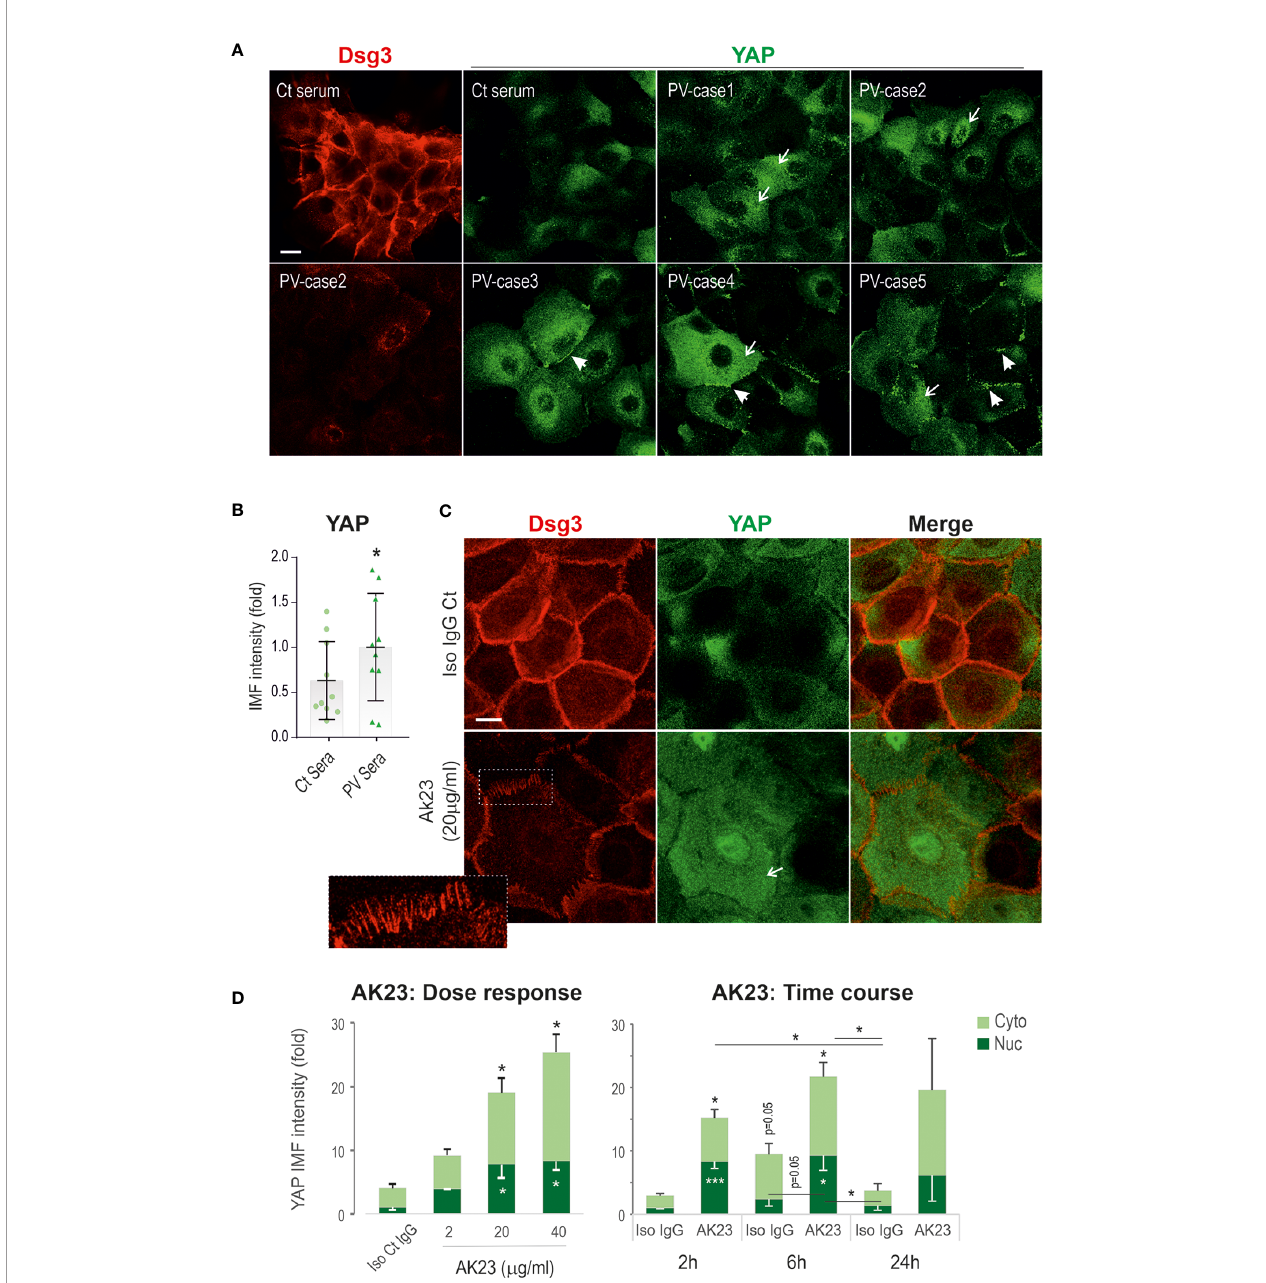
FIGURE 2 | Treatment of keratinocytes with PV sera or the pathogenic monoclonal antibody against Dsg3 results in increased YAP expression. (A) Confocal images of N/TERT cells double-labeled for Dsg3 (5H10, red) and YAP (green). Cells were seeded on coverslips at approximately 80% con fl uent densities (~2.5x10 5 /well) one day before being treated with PV sera (40%) in KSFM (Ca ++ 90µM) alongside control serum overnight. Then, the medium was replaced with KSFM with normal calcium (1.8mM) plus PV sera at the same concentration of 40% and cultured for further 5 hours (24 hours PV sera in total) before fi xation. Coverslips were immunostained for the indicated proteins. Increased cytoplasmic YAP (arrows) with aggregations at the cell borders (arrowheads) were shown in PV serum treated cells coupled with Dsg3 reduction. (B) Image quantitation of YAP staining shown in (A) (n=10 PV patients ’ sera, 2 experiments, the comparison was made by two- tailed Student t-test , *p<0.05). (C) N/TERT cells of ~80% con fl uence grown for one day were treated with AK23, the pathogenic monospeci fi c antibody against Dsg3, in KGM for 6 hours and dual labeled for Dsg3 (5H10) and YAP. The insert showed the characteristic linear arrays of Dsg3 staining (red) at the cell border, the feature of anti-Dsg3 mediated disruption as described previously (42). Elevated YAP levels were shown in both the nuclei (Nuc) and cytoplasm (Cyto) of AK23 treated cells compared to the counterpart treated with isotype IgG1 control (Iso Ct IgG). Reduction of Dsg3 staining was observed in cells treated with AK23. (D) Image quanti fi cation for the dose and time-course experiments (normalized to control nuclear signal that was arbitrarily set as 1), with AK23 (2 µg/ml used in the time course study) (n=4 fi elds/sample, 2 experiments for dose and 3 experiments for time course, mean ± SEM, one-way ANOVA was used to obtain the p values (*p<0.05, ***p<0.001). Data were representative of at least three independent experiments. Scale bars,